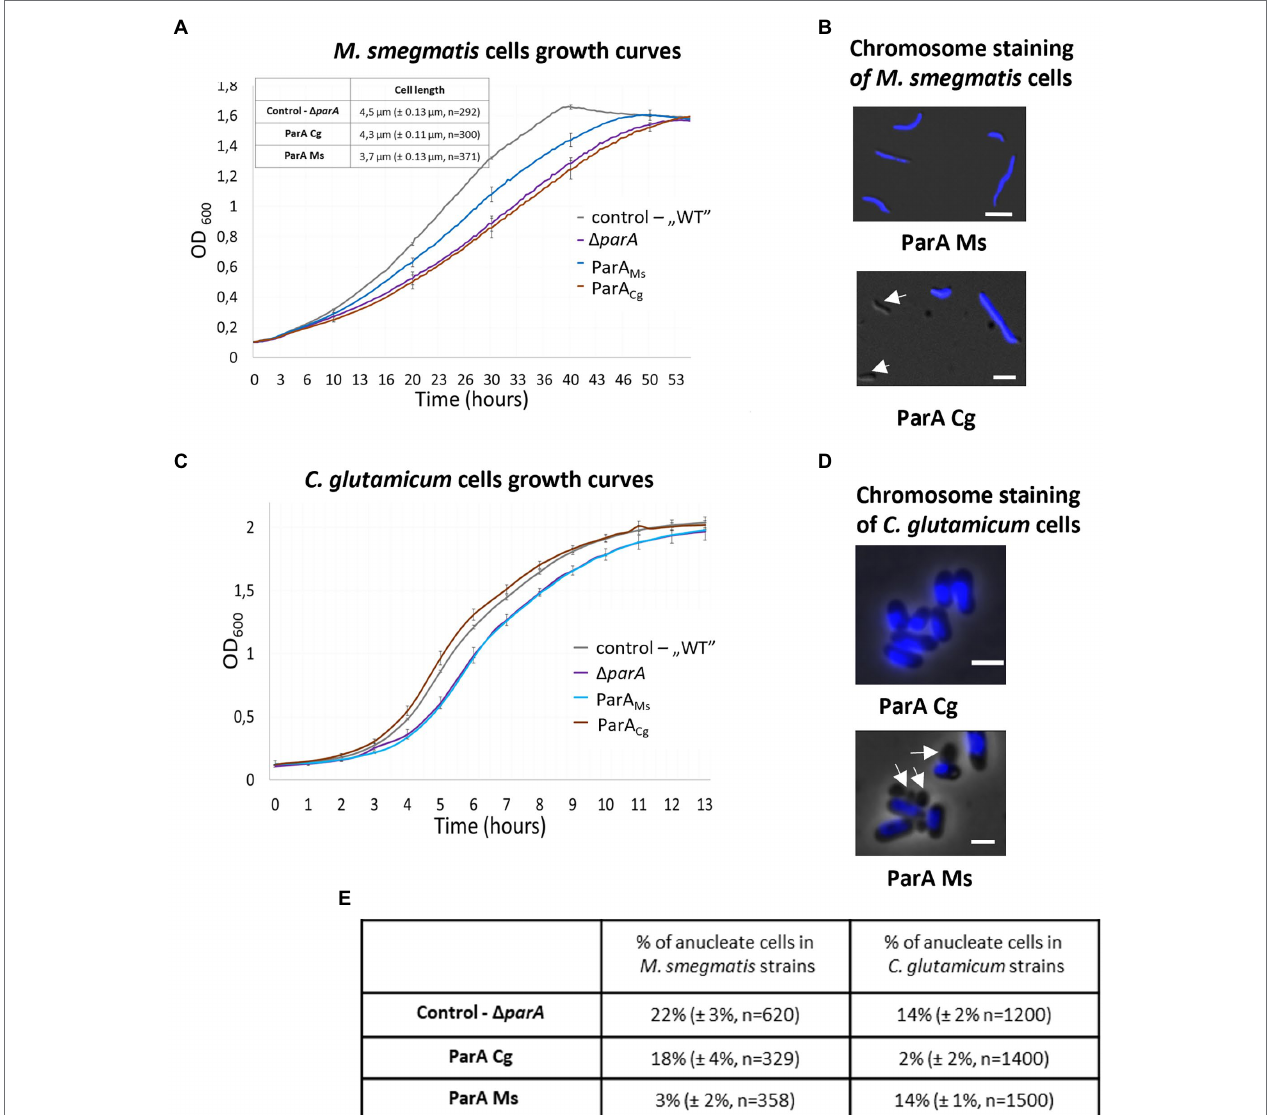
FIGURE 6 | Lack of complementation of the C. glutamicum and M. smegmatis parA deletion strains with the heterologous parA. (A) Culture growth curves of the M. smegmatis parA deletion strain complemented with its own (ParA Ms ) and C. glutamicum (ParA Cg ) parA gene. M. smegmatis WT with empty vector pMVp ami and parA mutant served as controls. The results represent the average of three independent experiments obtained using a Bioscreen C instrument. Bars indicate SEs. Inset: cell length of M. smegmatis strains obtained by microscopy. M. smegmatis Δ parA served as a control (the number of cells analysed, n , is indicated). (B) Microscopic images of M. smegmatis parA mutants complemented with its own (ParA Ms ) and C. glutamicum (ParA Cg ) parA gene. Blue fluorescence of nucleoids stained with DAPI is merged with DIC. Arrows indicate anucleate cells. Scale bar: 2 μ m. (C) Culture growth curves of C. glutamicum parA mutants complemented with its own (ParA Cg ) and M. smegmatis (ParA Ms ) parA gene. C. glutamicum WT with empty vector pEKEX and parA mutant served as controls. The results represent the average of three independent experiments obtained using a Bioscreen C instrument. Bars indicate SEs. (D) Microscopy images of the C. glutamicum parA deletion strain complemented with its own (ParA Cg ) and M. smegmatis (ParA Ms ) parA gene. DIC images are merged with blue fluorescence of nucleoids stained with Hoechst3342. Arrows indicate anucleate cells. Scale bar: 2 μ m. (E) The percentage of anucleate cells identified in the images of the DAPI-stained cells of analysed M. smegmatis and C. glutamicum parA mutant strains complemented with M. smegmatis (ParA Ms ) and C. glutamicum (ParA Cg ) parA . Deletion strains served as control. The experiment was performed in two independent biological replicates. The number of calculated cells is indicated as n . The 95% of CI was indicated as